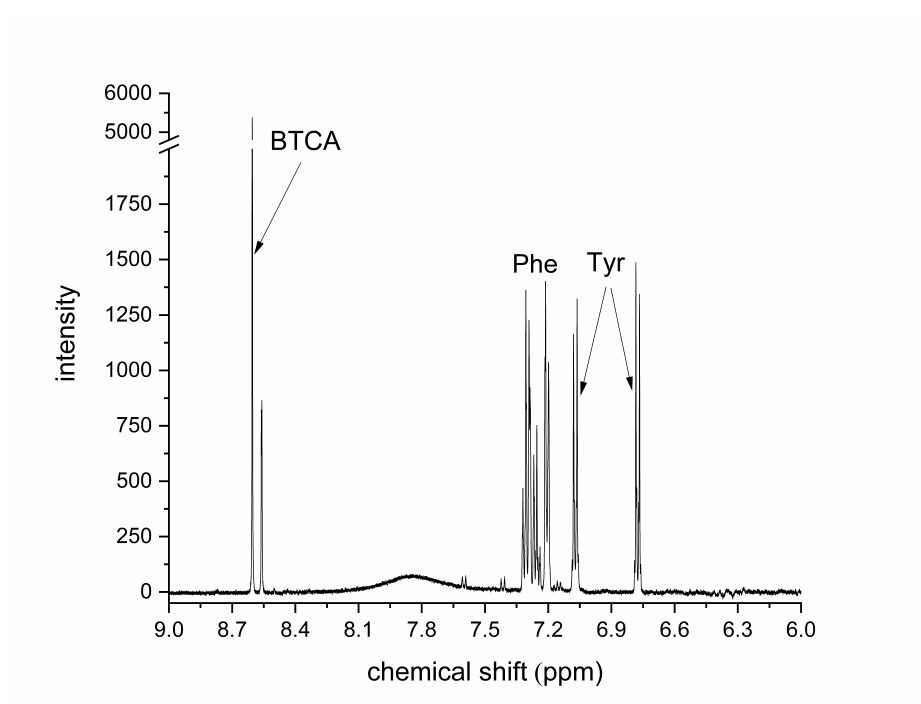
Figure 7. Aromatic region of 1 H-qNMR spectrum of hydrolyzed BSA, 0.25 mM, using 3.3 mM of